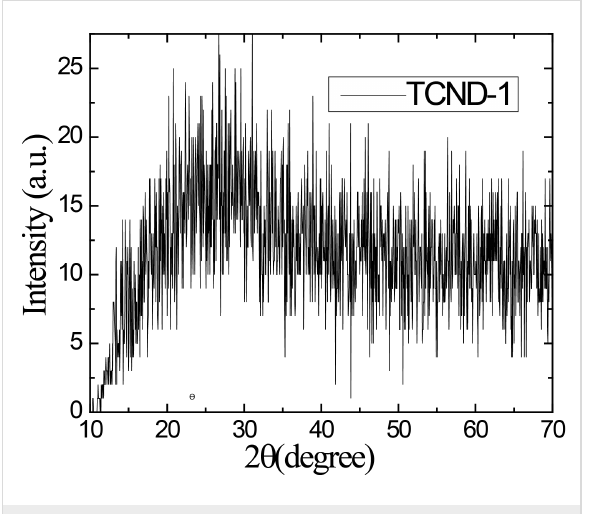
Figure 1: X-ray diffraction pattern of synthesized tyrosine passivated CNDs at 220 °C.